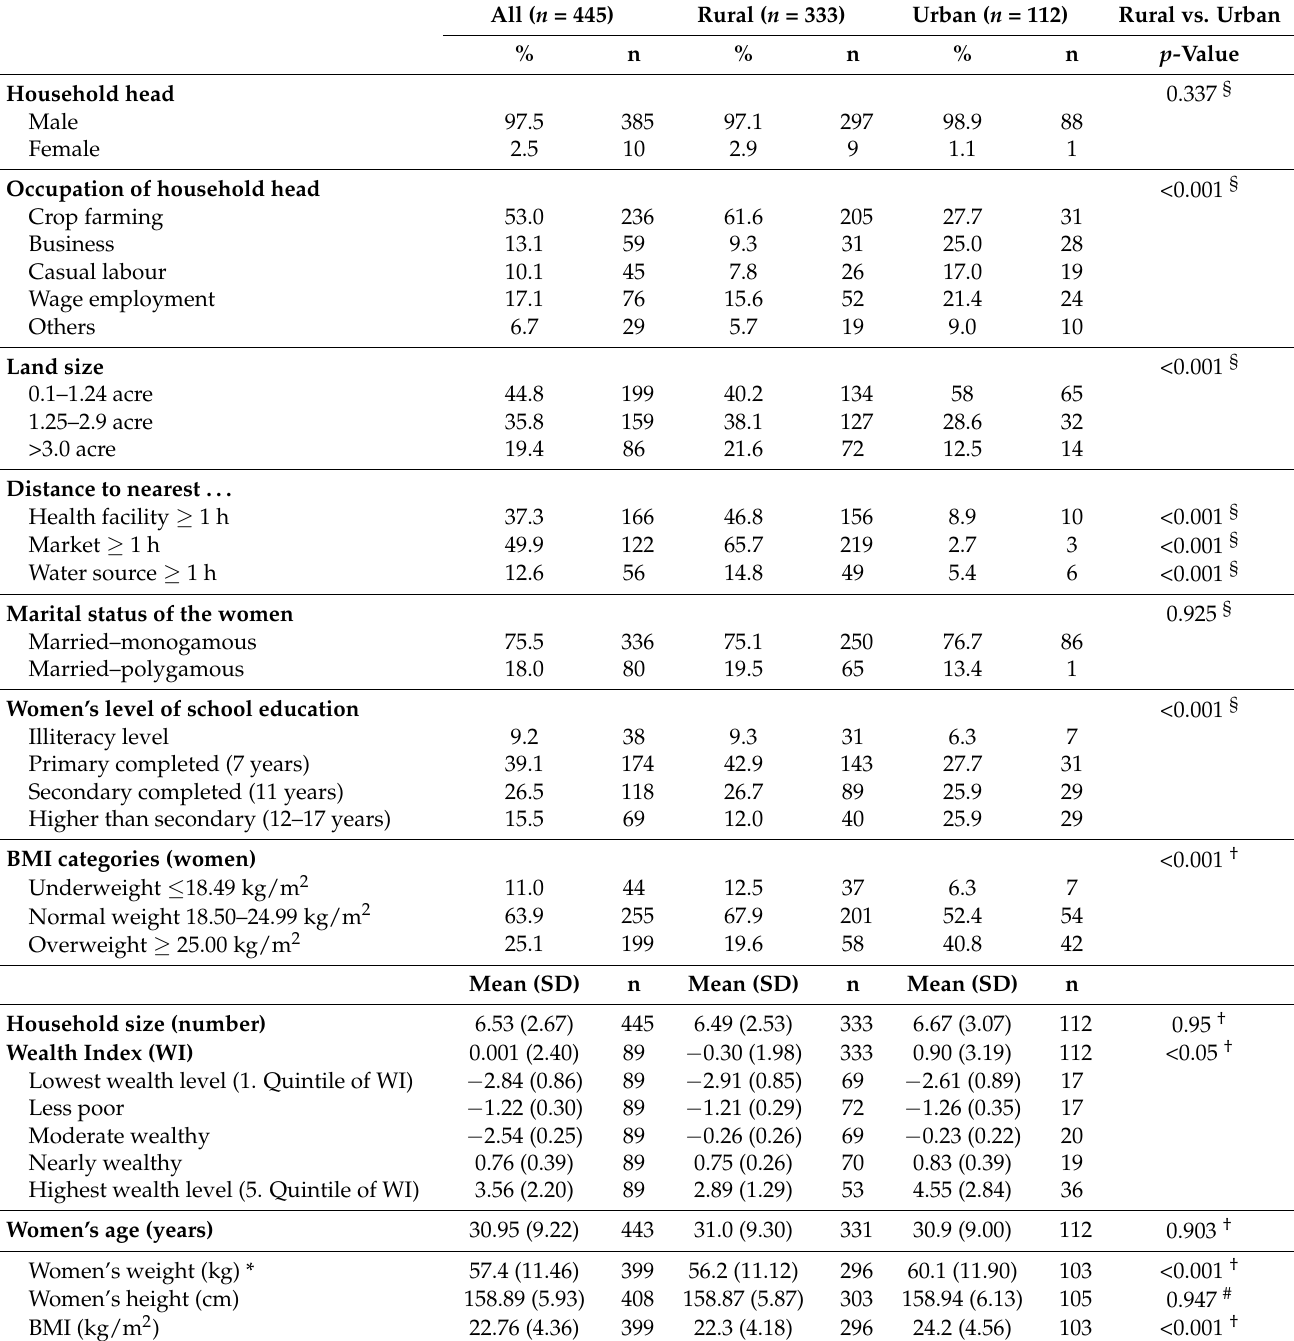
Table 1. Households’ main characteristics stratified by rural and urban areas at baseline (May